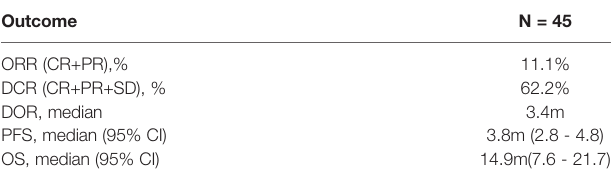
TABLE 2 | Response